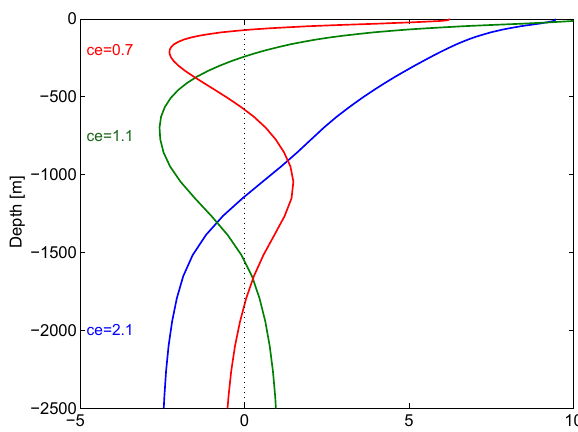
Figure 16. Vertical structure of the ETNA baroclinic modes 1 (blue), 2 (green), and 3 (red) for pressure and horizontal velocities (upper 2500m only). Calculation is made using TROP025 strati- fication at 14 ◦ N, 18 ◦ 30 (cid:48) W. The associated reduced gravity phase speed ce (s − 1 ) for each mode is also indicated.